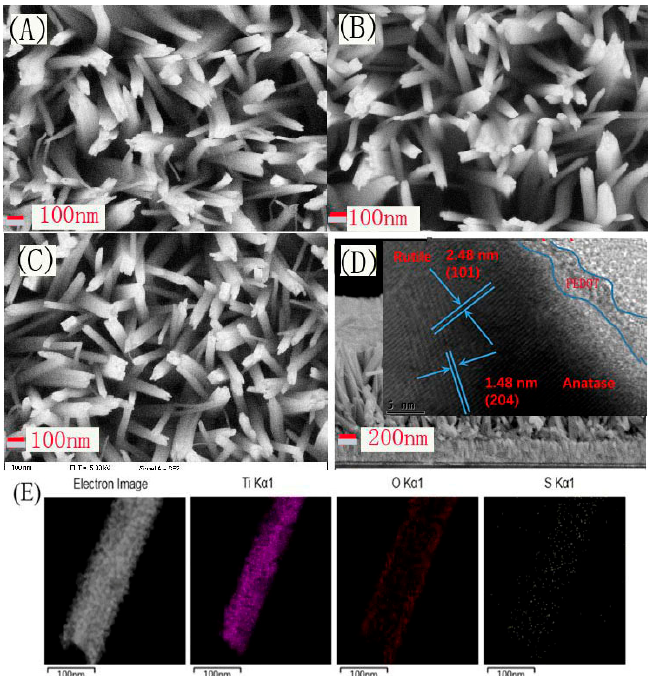
Figure 2. SEM images of ( A ) TiO 2 , ( B ) hydrogen treated TiO 2 (H-TiO 2 ), ( C ) PEDOT modified hydrogen